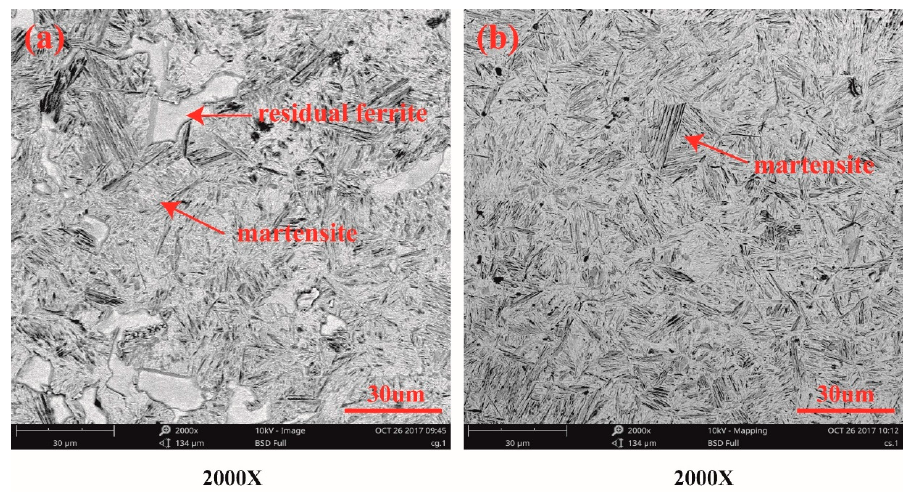
Figure 3. Microstructure of 35CrMoV: ( a ) un-ultrasonic-aided; ( b ) ultrasonic-aided.